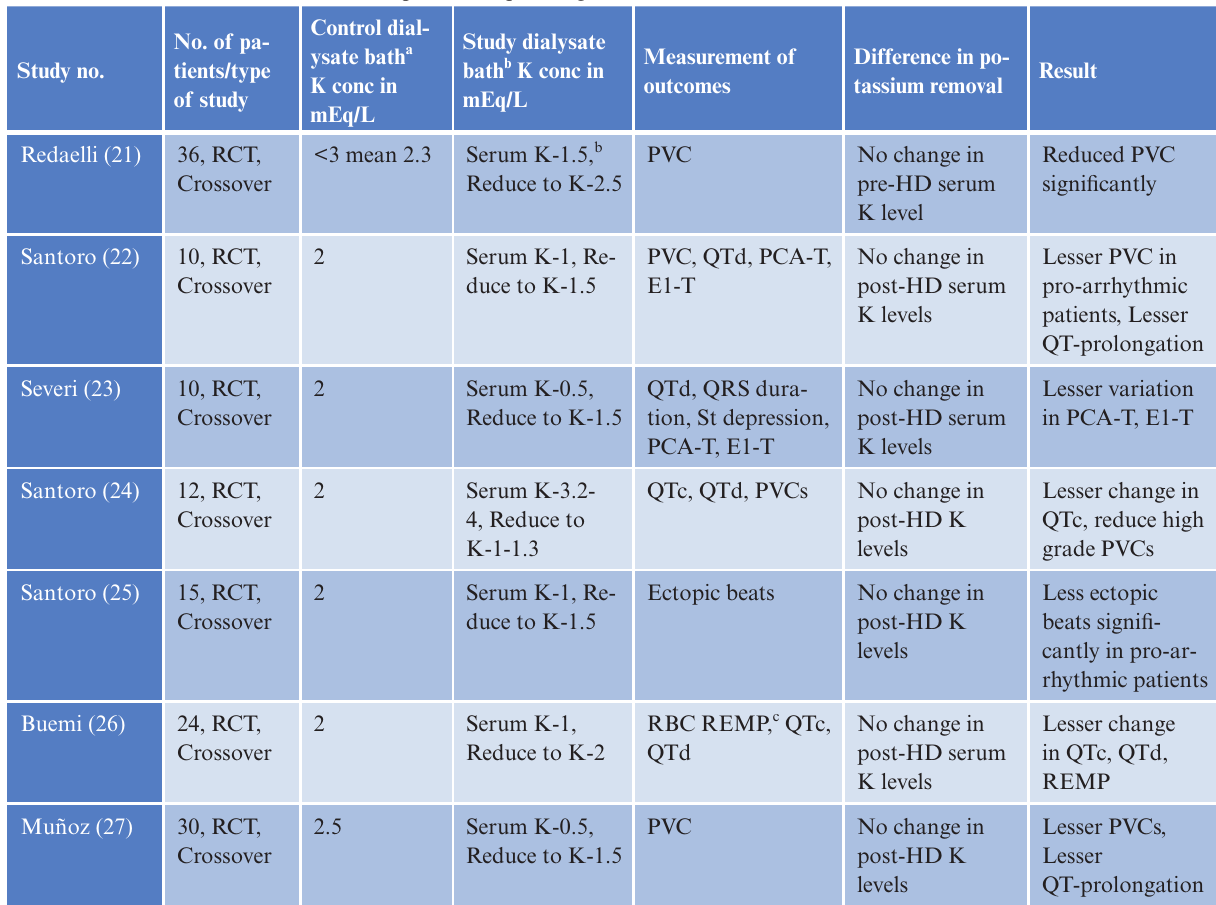
Table 1. Randomized controlled trials on potassium profiling.